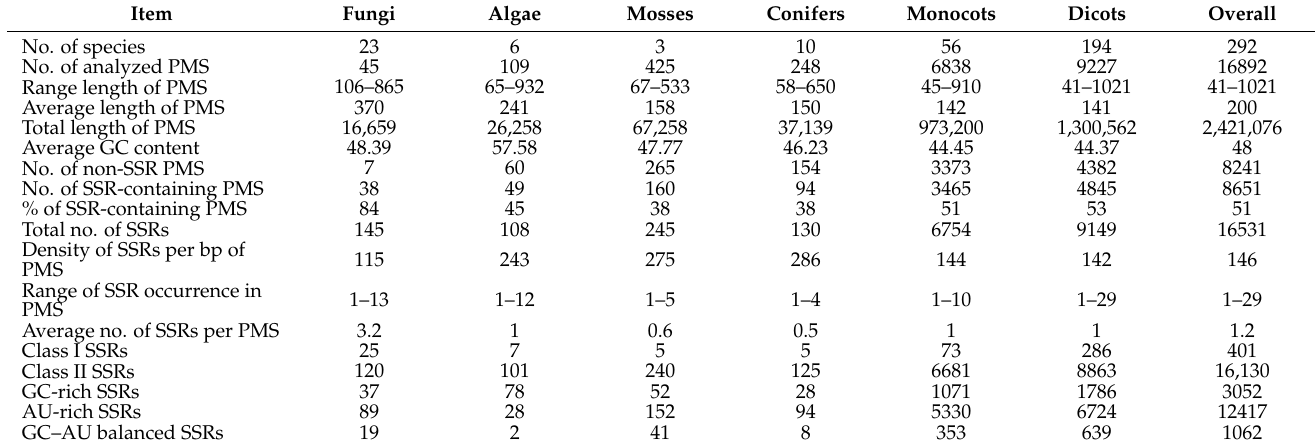
Table 1. Summary of in silico simple sequence repeat (SSR) mining in plant pre-microRNA sequences (PMS). Item